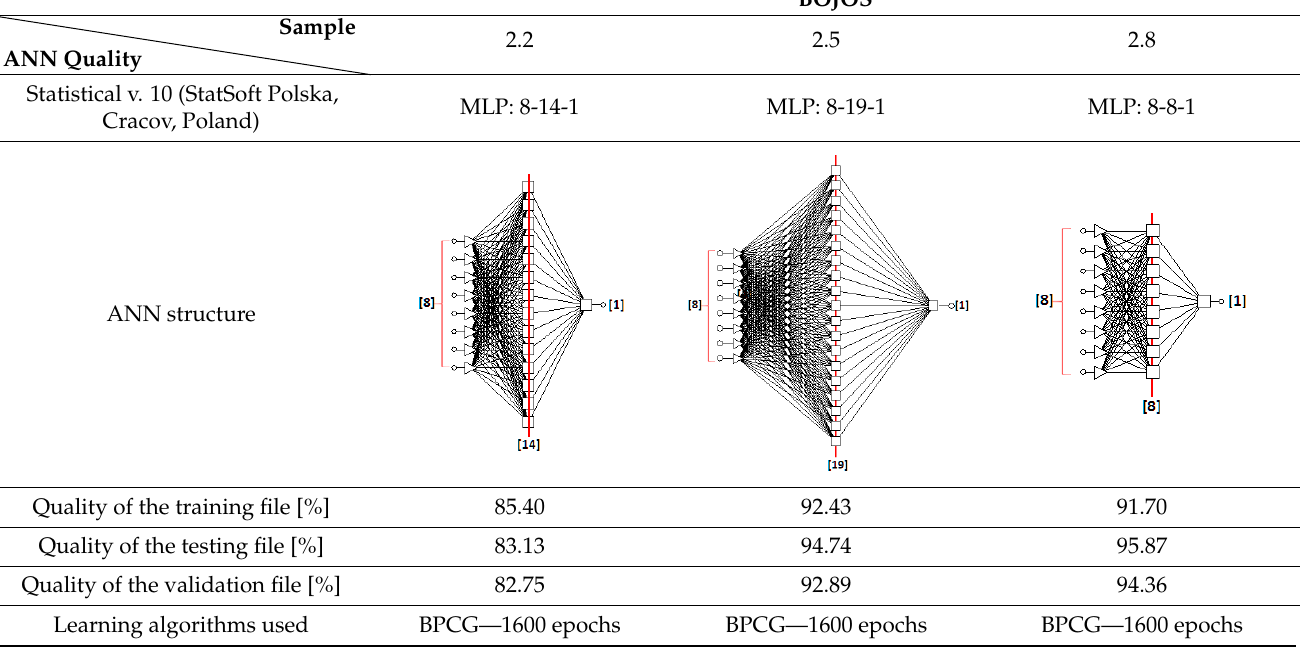
Table 6. Best neural network models for each fraction of the BOJOS variety samples.